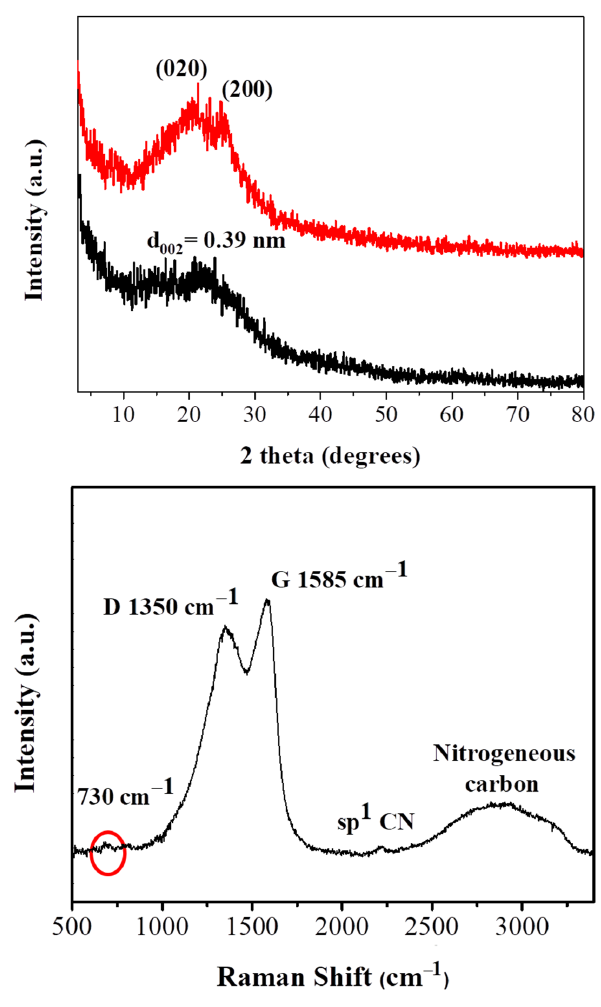
Figure 1. X-ray diffraction (XRD) pattern (top black line) and Raman spectrum (bottom) of the carbon sample. The XRD pattern of PANI is also presented for comparison (top red line).